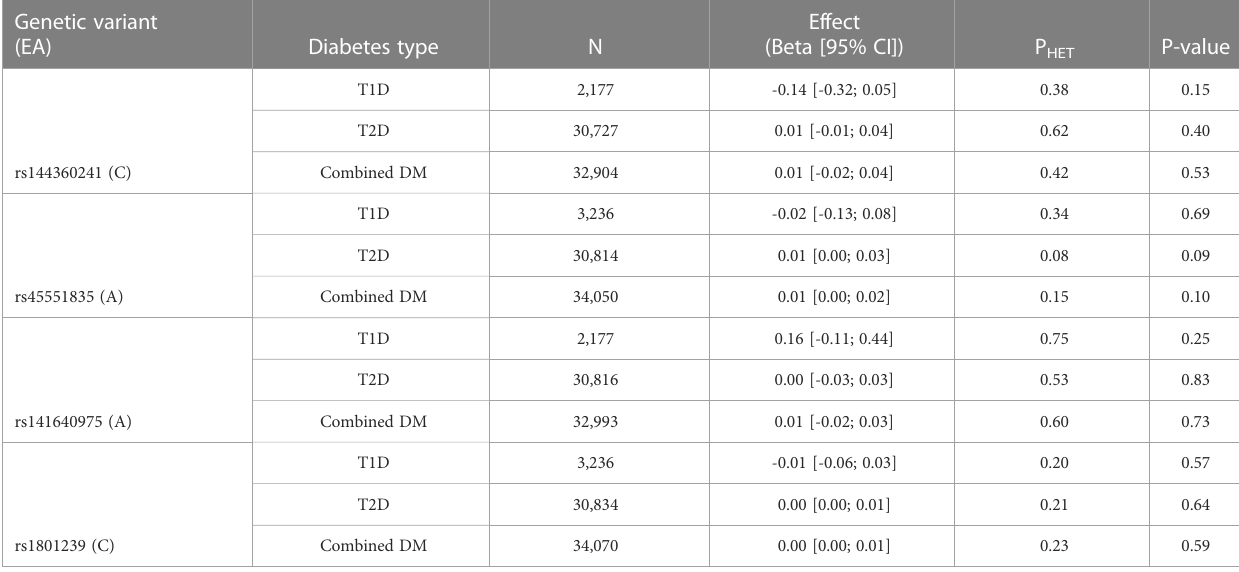
TABLE 2 meta-analysis of SNV-eGFR creatinine summary data in diabetes mellitus and its subtypes (model 1).